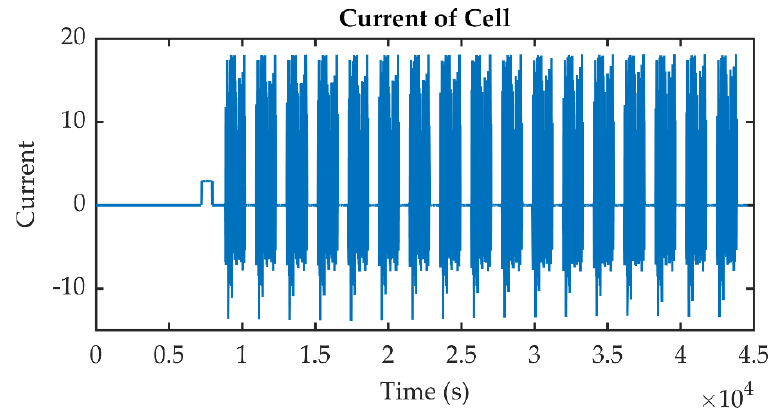
Figure 5. Battery current characteristic.